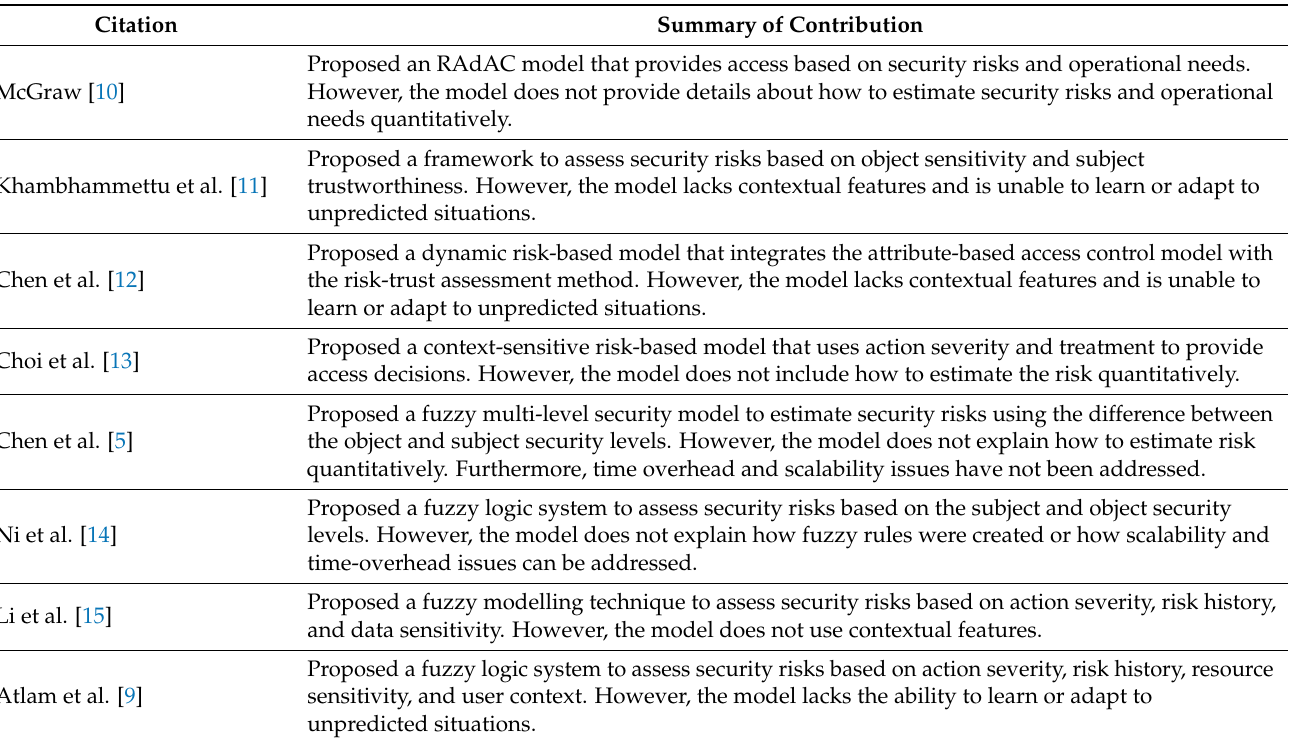
Table 1. Summary of related